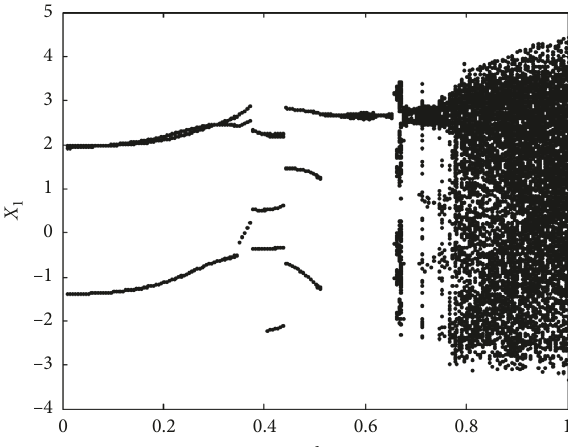
Figure 2: The displacement bifurcation graph of velocity pulsation amplitude ( Ω � 2, ω � 1, c � 0.05, r � 0.5, p � 10, c � 0.5, and the initial value is [0.01, 0, 0.01,